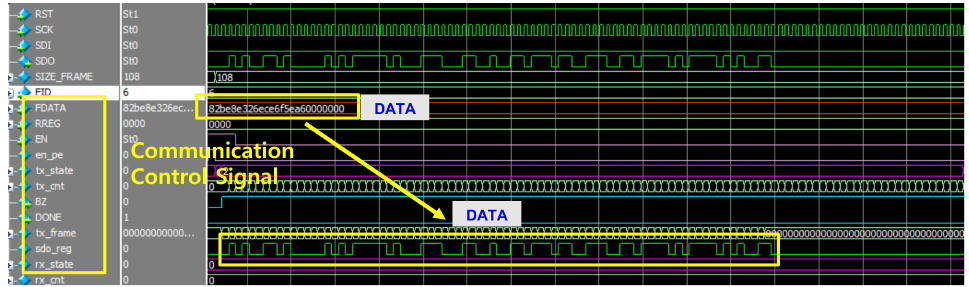
Figure 15. The simulation results of communication and control interface.